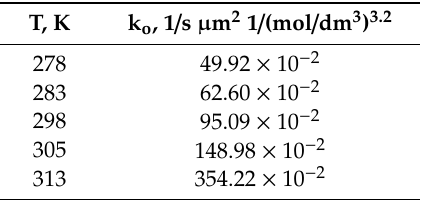
Table 2. Intrinsic reaction rate constants for the malachite leaching in NH 4